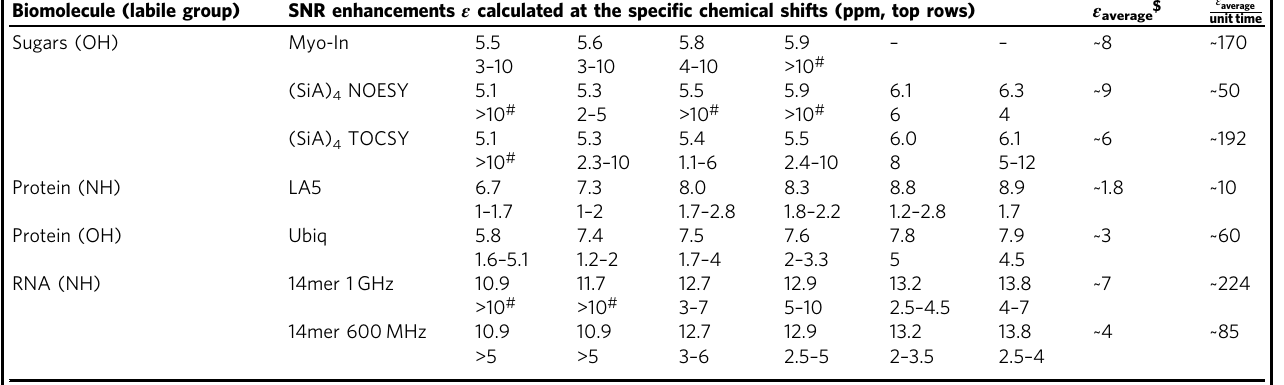
Table 1 SNR enhancements ε extracted upon comparing the various 2D HMT and conventional NOESY and TOCSY spectra collected in this study, for the acquisition times indicated in the corresponding